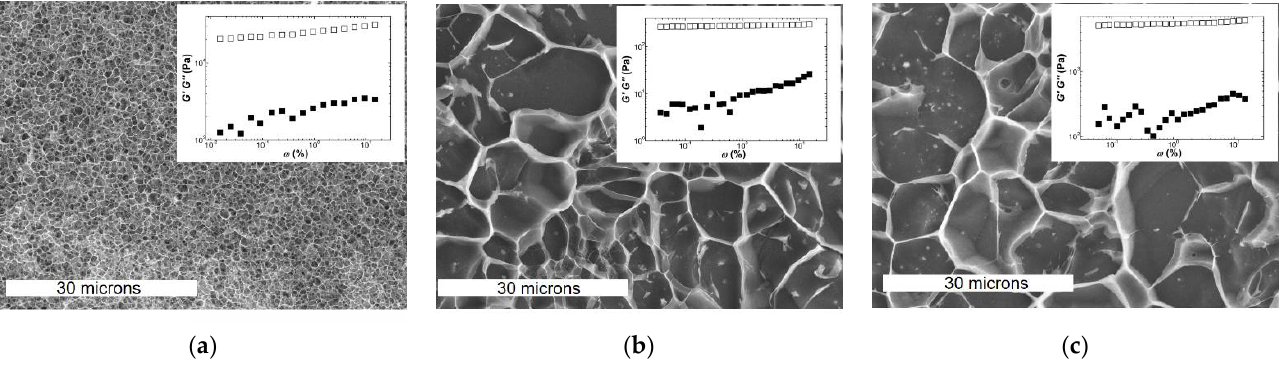
Figure 3. CryoSEM pictures and mechanical spectra (insets) of gels formed with 2 wt.% carrageenan at 20 °C for: ( a ) Kappa in 0.1 NaCl; ( b ) Iota in 0.1 NaCl; ( c ) Kappa2 in 0.1 KCl. White bars in CryoSEM pictures indicate 30 microns.